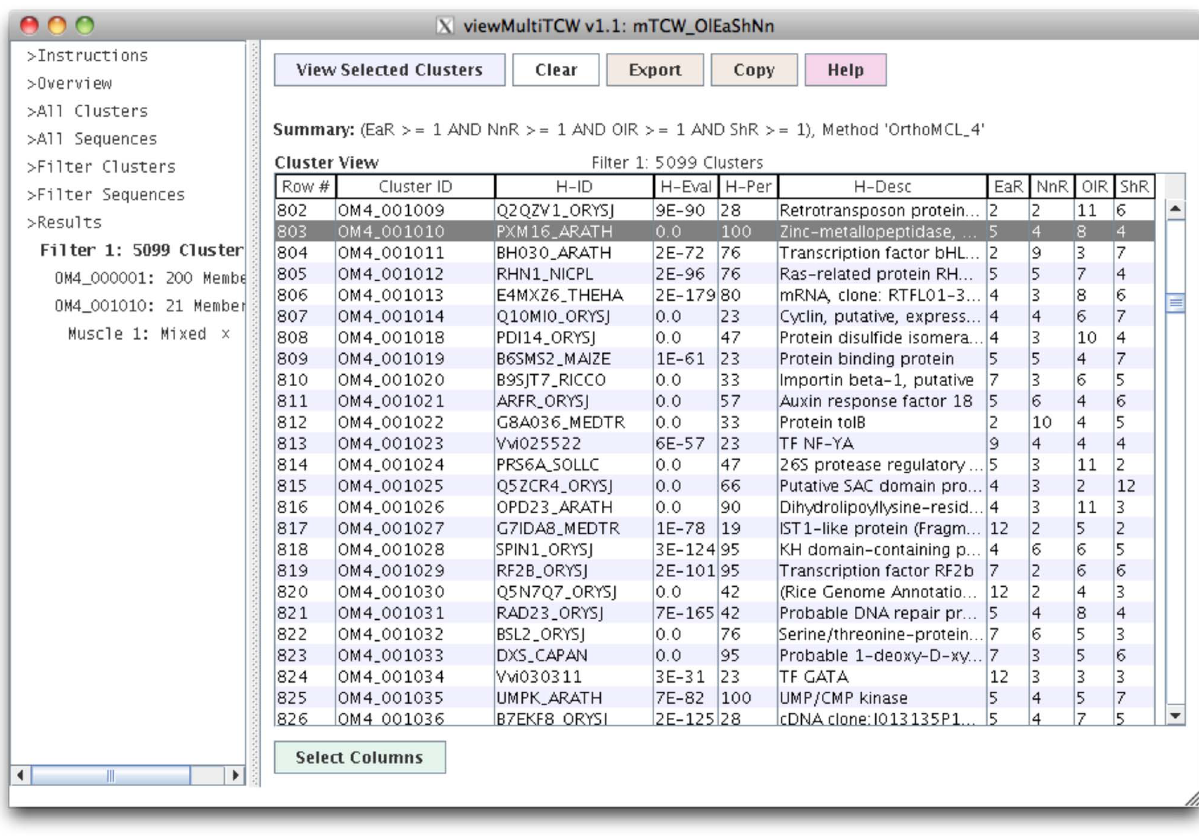
Figure 5. The viewMultiTCW interface. This shows the table of orthoMCL inflation 4.0 clusters where there is at least one sequence from each species. The H-ID and H-Desc columns are the annotation hit that the majority of the sequences have, e.g. for cluster OM4_0001010, 100% have the hit PXM16_ARATH where the best of them has an e-value of 0.0. The columns can be changed by selecting the ‘‘Select Columns’’ at the bottom, which will immediately change the table (i.e. a new search of the database is not